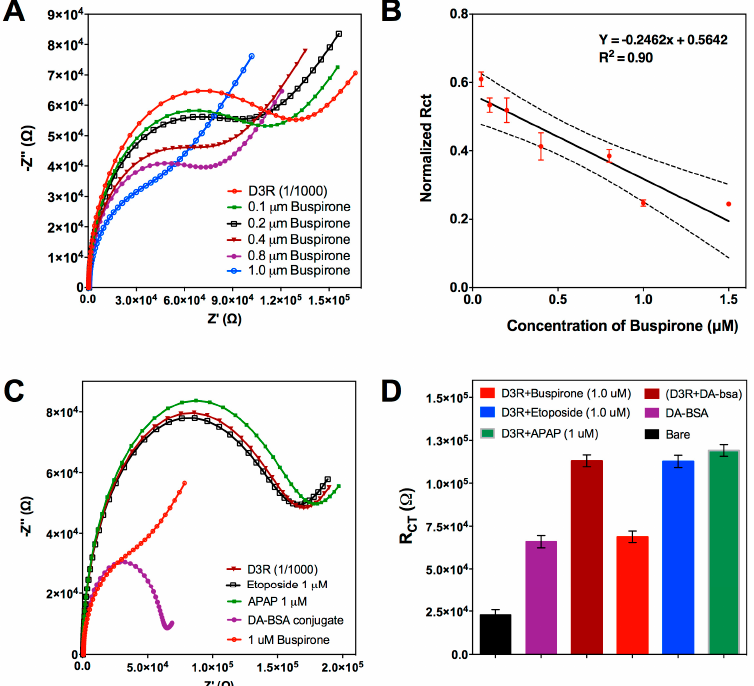
Figure 3. Electrochemical inhibition assay for buspirone. ( A ) Nyquist plots drawn for various buspirone concentrations (0.1, 0.2, 0.4, 0.8, 1.0 μ M). ( B ) Calibration curve of EC biosensor for indirect concentrations (0.1, 0.2, 0.4, 0.8, 1.0 µ M). ( B ) Calibration curve of EC biosensor for indirect buspirone detection based on normalized R ct values. Each value represents mean and standard deviation of five measurements. ( C ) Nyquist plots drawn for control studies performed with Etoposide and APAP at the same concentration of buspirone (1.0 µ M). ( D ) Bar graphs with mean and SD ( n = 5) for signal comparison between control drugs and buspirone at the same concentration (1.0 µ